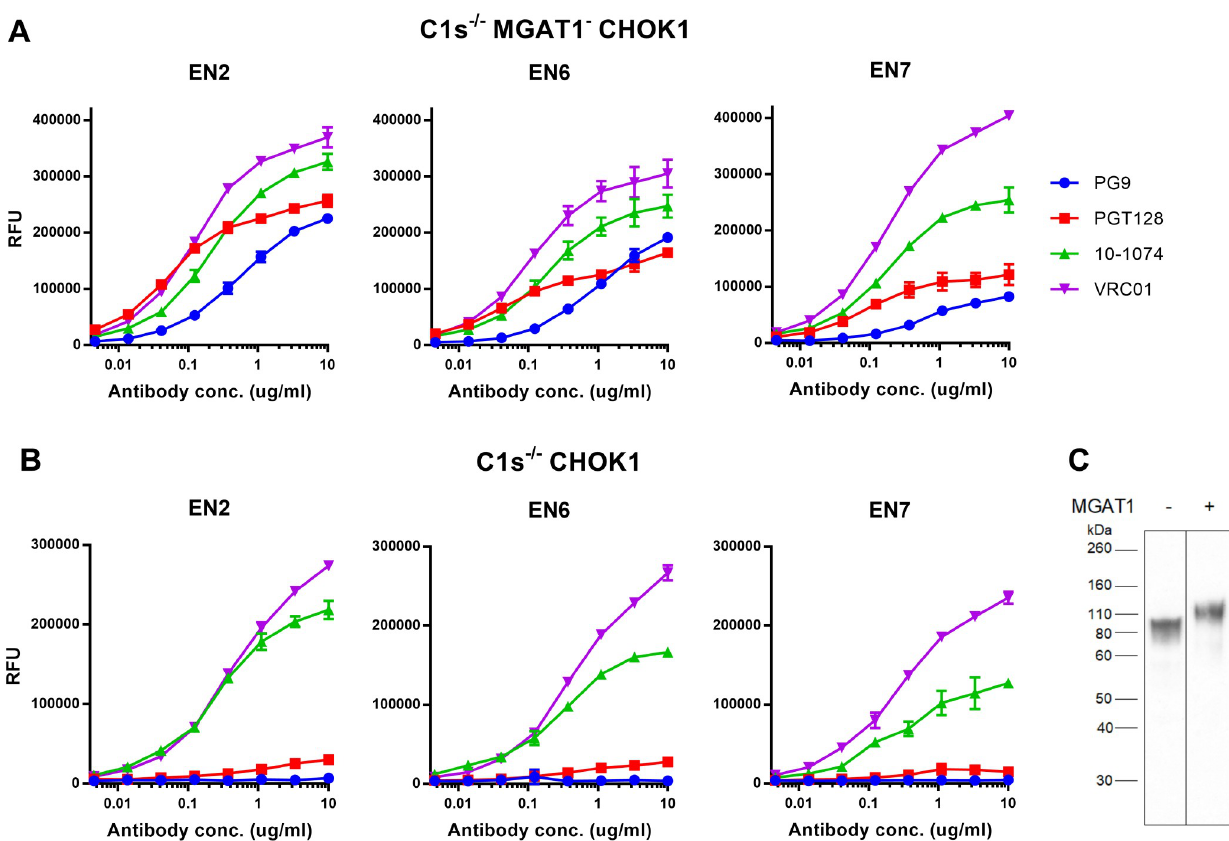
Fig 4. Enhanced binding of glycan-dependent bN-mAbs to clade B rgp120s expressed in cell lines deficient in C1s and MGAT1. A. Plasmids encoding three different gp120s (EN2, EN6, and EN7) were transfected into the C1s -/- MGAT1 - CHOK1 1.A1. Diluted cell culture supernatants were collected after 4 days, captured with the 34.1 mAb for a capture fluorescence immunoassay (FIA) and assayed against a panel of bN-mAbs. B. The same EN2, EN6 and EN7 rgp120 monomers were transiently expressed in the C1s -/- CHOK1 2.E7 cell line to show differences in antigenicity due to knockout of MGAT1 when compared to the C1s -/- MGAT1 - CHOK1 1.A1 cell line. All assays were performed in triplicate. C. EN2 was expressed in the C1s -/- MGAT1 - CHOK1 1.A1 cell line, indicated with a (-), and the C1s -/- CHOK1 2.E7 cell line, indicated with a (+). Growth-conditioned cell supernatant was immunoblotted with an anti-rgp120 goat polyclonal